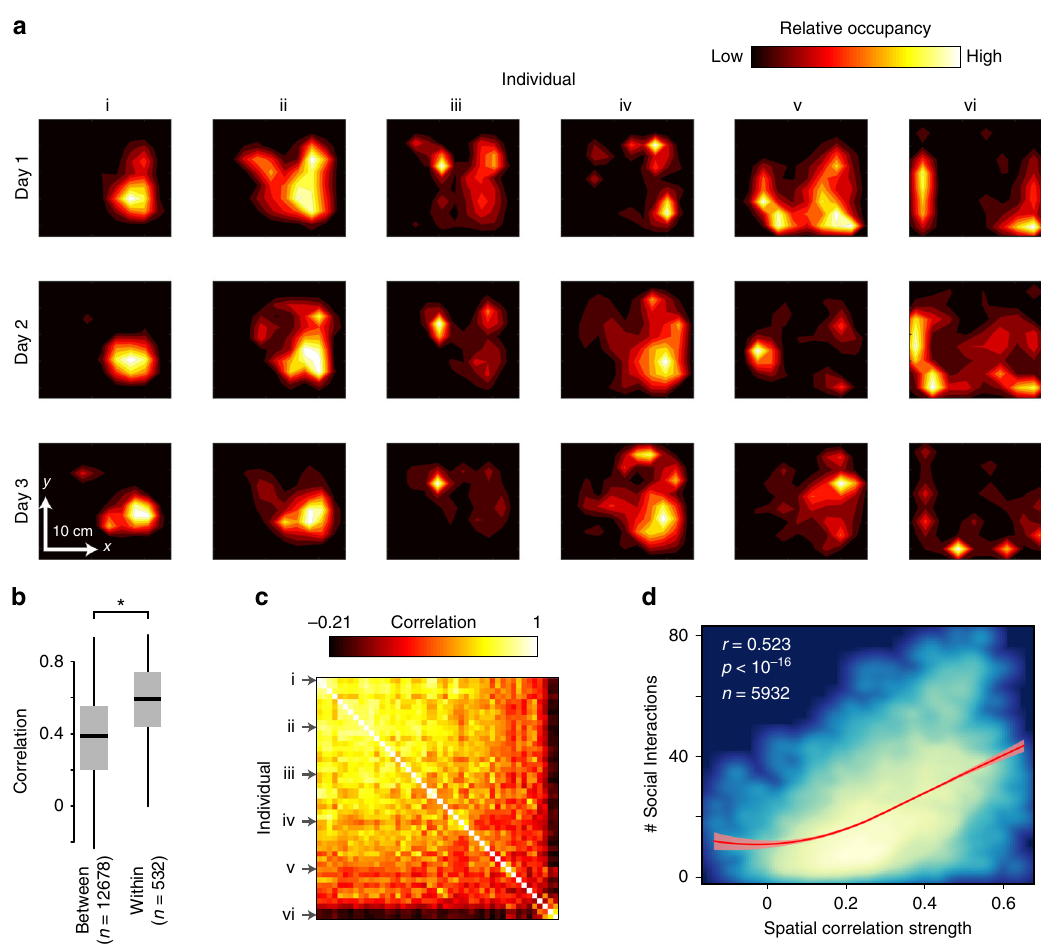
Fig. 3 Workers show variable and repeatable patterns of spatial fi delity within the nest. a Representative spatial occupancy patterns within the nest of six bumble bee workers (i – vi) over three days from a single colony. Color indicates relative occupancy, smoothed by kernel density estimation. b Correlation of spatial occupancy within and between individuals across days from the same colony. Boxplots show the median and inter-quartile range (IQR), while whiskers depict the data range (75th and 25th ± 1.5*IQR, respectively). c Correlation matrix of spatial occupancy patterns between all workers for a single day from a single colony (same as in Fig. 1). Rows corresponding to the six individual workers (i – vi) shown in a are indicated by arrows. Color indicates correlation strength. d Relationship between mean spatial correlation strength to other bees (as in c ) and the number of unique social interactions engaged in by that individual, across all days and colonies. Color indicates density of points, from blue to light yellow. Spearman correlation coef fi cient = 0.523. Thick red line shows local smoothing estimate (Loess) and ±95% CI (in light